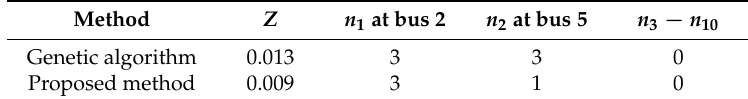
Table 4. Mean values of least upper bound Z and f (cid:96) .